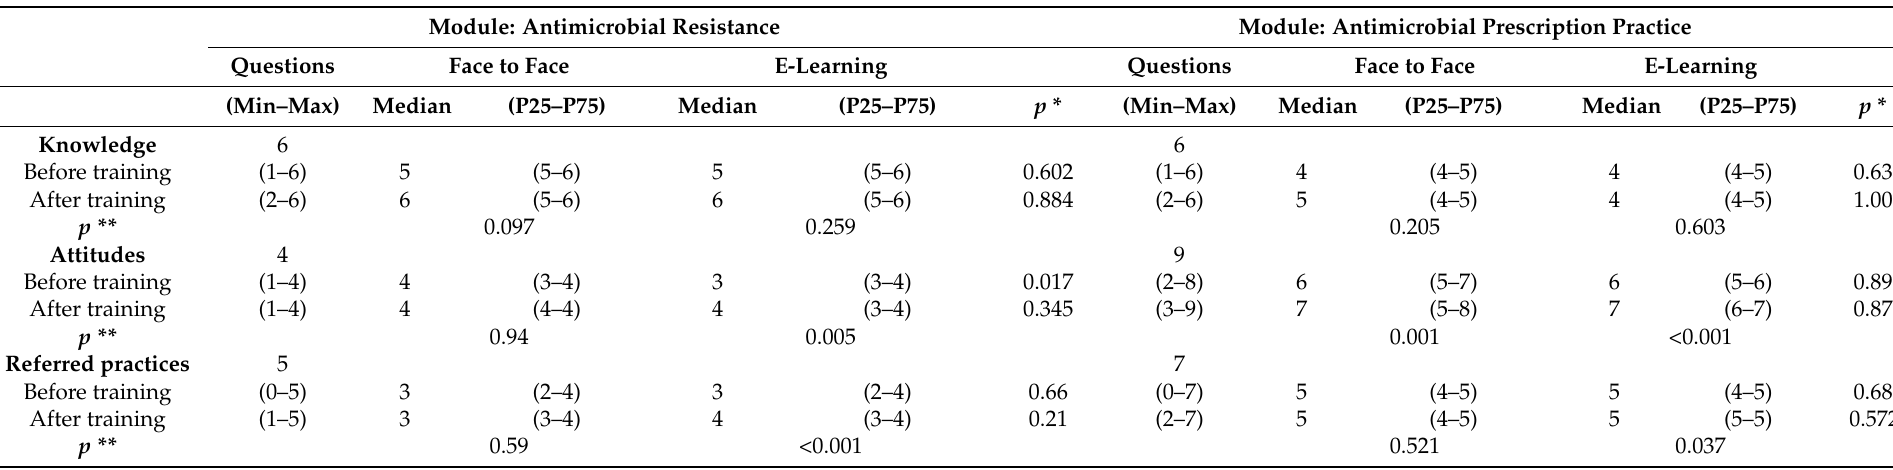
Table 1. Effect of the training modality on knowledge, attitudes and referred practices before and after the educational